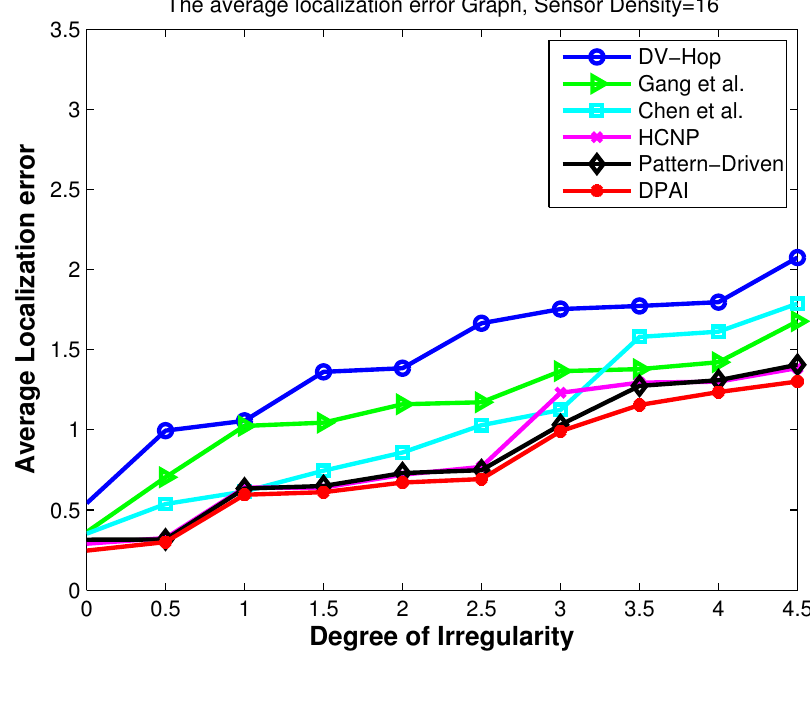
Figure 10. Localization error vs . DOI.